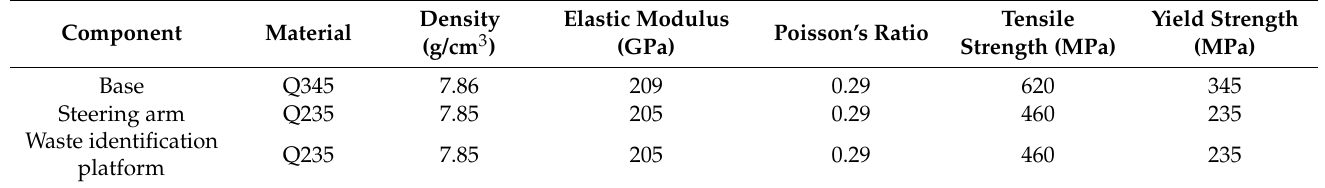
Table 1. Material properties of each component for the mechanisms.